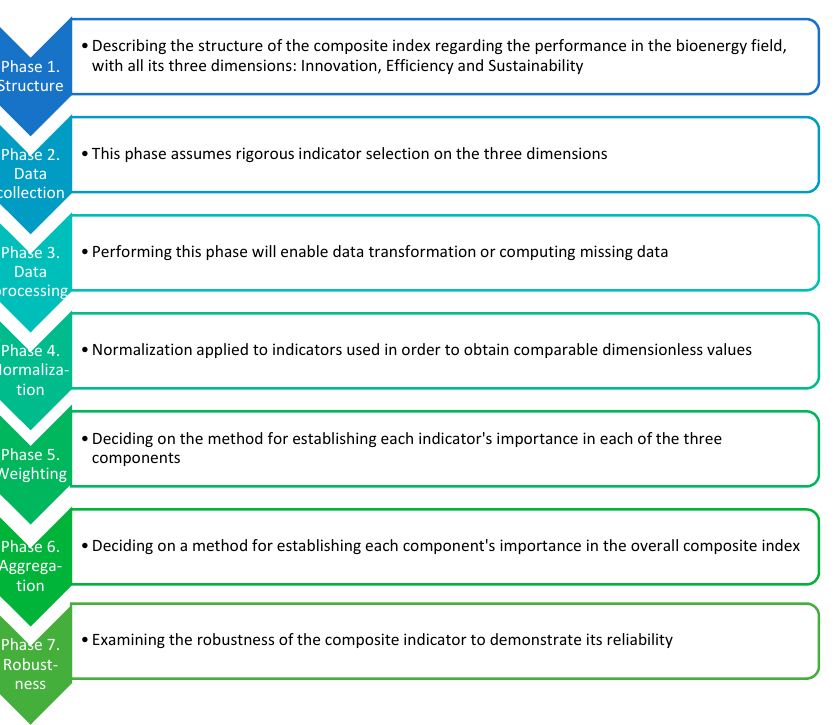
Figure 1. Research methodology. Source: authors.